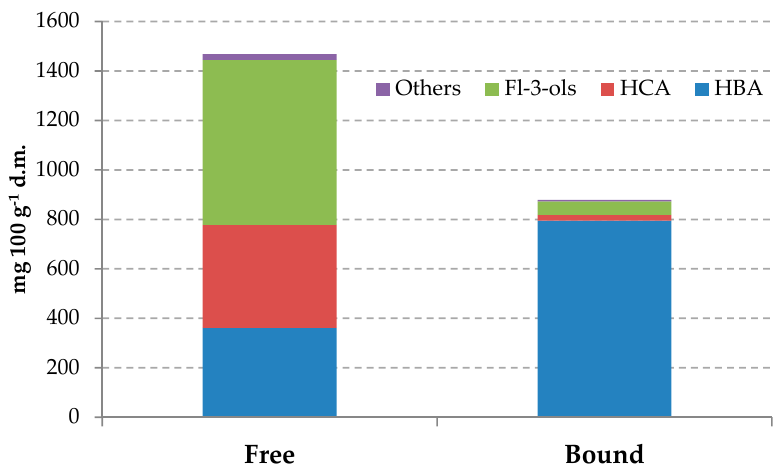
Figure 1. Distribution of phenolic compound classes in free and bound fraction. HBA, hydroxybenzoic acid derivatives; HCA, hydroxycinnamic acid derivatives; Fl-3-ols, flavan-3-ol derivatives.